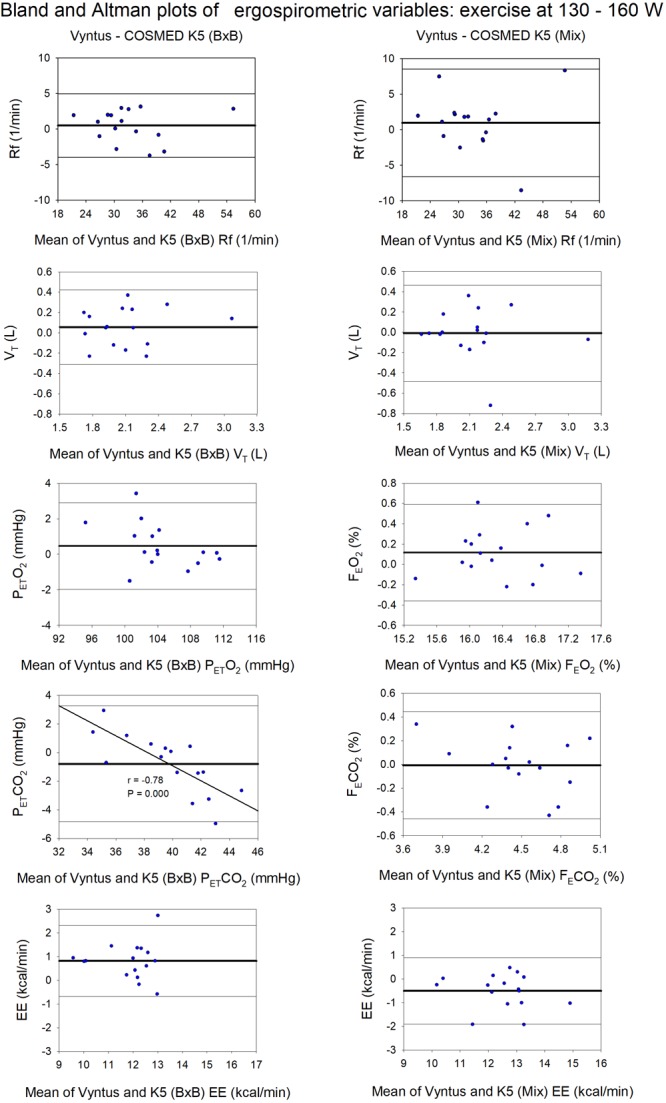
Agreement between Vyntus (used as a reference stationary metabolic cart) and COSMED K5 operated Breath-by-Breath (B×B) and in Mixing Chamber (Mix) modes during moderate-intensity (130–160 W) exercise for respiratory frequency (Rf), tidal volume (VT), end-tidal O2 pressure (PETO2), expiratory O2 fraction (FEO2), end-tidal CO2 pressure (PETCO2), expiratory CO2 fraction (FECO2), and energy expenditure (EE). N = 16.